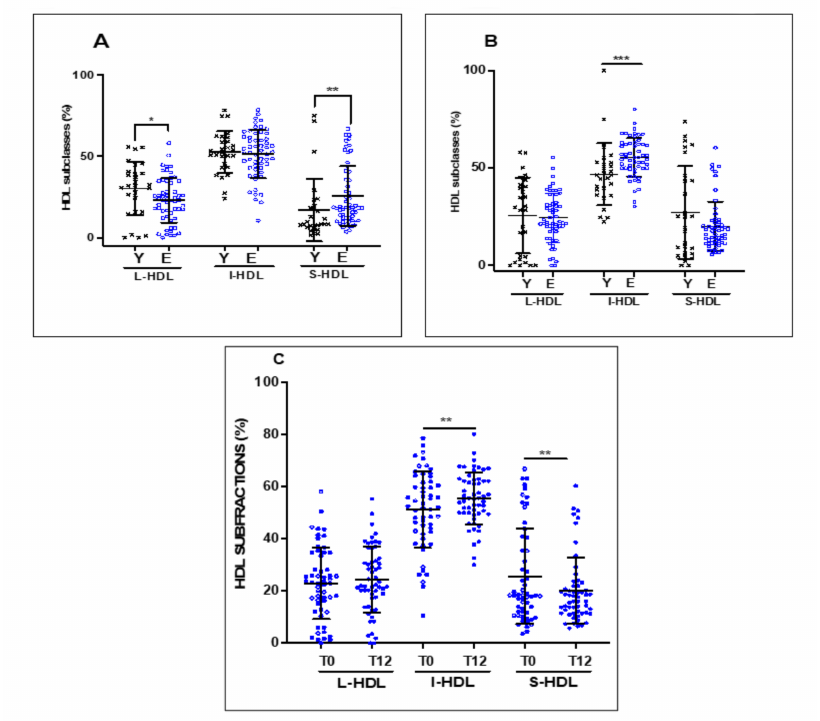
Figure 5. Effect of age and EVOO intake on the distribution of HDL subclasses. Plasma from healthy young subjects was obtained at recruitment and after EVOO intake. The plasma was subjected to electrophoresis in 3% polyacrylamide Lipoprint® HDL gel tubes. The gel tubes were analyzed using Lipoware software. Distribution profiles of HDL subclasses ( A ) at baseline, ( B ) after 12 weeks of EVOO intake for both young and elderly, and ( C ) for elderly only. Results are expressed as mean ± SD ( n = 27 healthy young and n = 57 healthy elderly subjects). * p < 0.03, ** p < 0.002, and *** p <